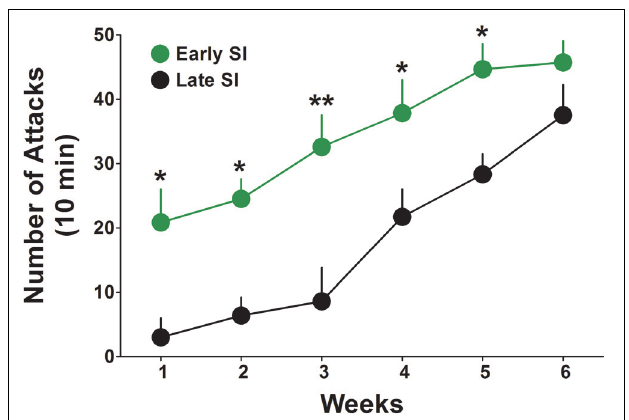
FIGURE 1 | Onset of aggressive behavior in early and late adolescent SI mice. Representation of the development of the aggressive behavior in early (green) and late (black) adolescent SI mice from week 1 to 6 of social isolation. Early adolescent social isolation (started at day 21 of life, PND 21) induced a more severe development of aggression compared to late adolescent isolation (started at day 45 of life, PND 45). Data represent the mean ± SEM of 15 mice. ∗ p < 0.05 and ∗∗ p < 0.001, when compared with late adolescent SI mice at the same time point.